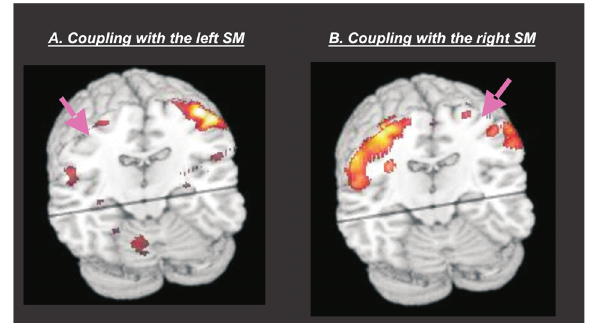
Figure 5. Group results of the connectivity analyses. The figure shows a 3D rendering of the F-statistics testing for PPIs with the left SM-region ( panel A ) and the right SM-region ( panel B ). The pink arrows illustrate the approximate location of the seed-region that was used in the two PPI analyses. The results revealed high inter-regional coupling within entire SM-network (homologous SM-region in the opposite hemisphere, SII in the parietal operculum, cere- bellum, and SMA). Additional t-tests revealed that the coupling was maximal in the Rest condition and that it decreased during passive movement stimulation (see also Table 2 ).